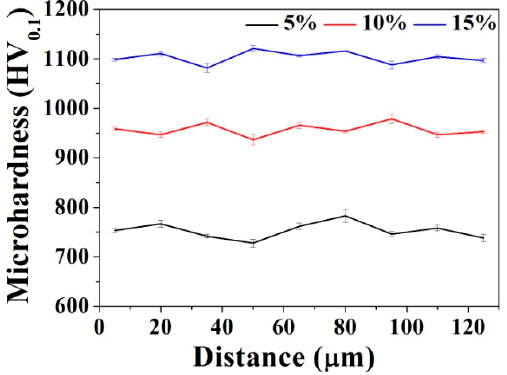
Figure 5. Microhardness value of the coatings.